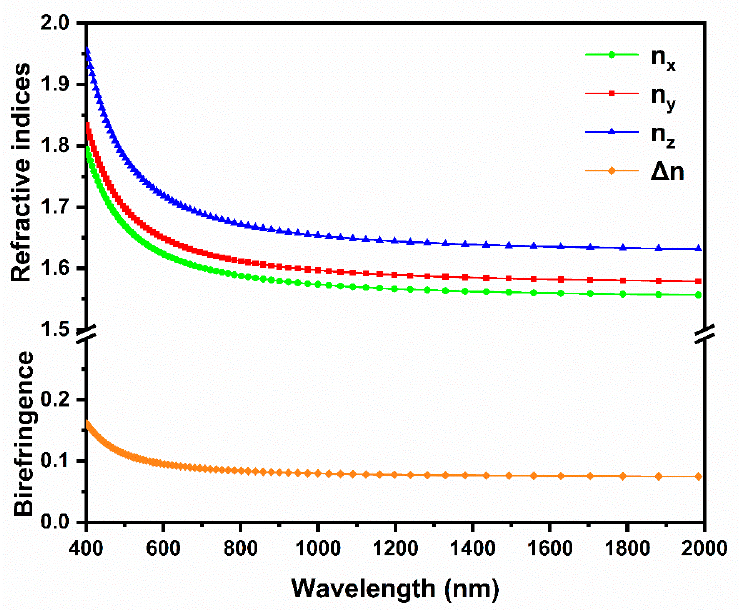
Figure 8. Calculated dispersive refractive index and Birefringence curves.